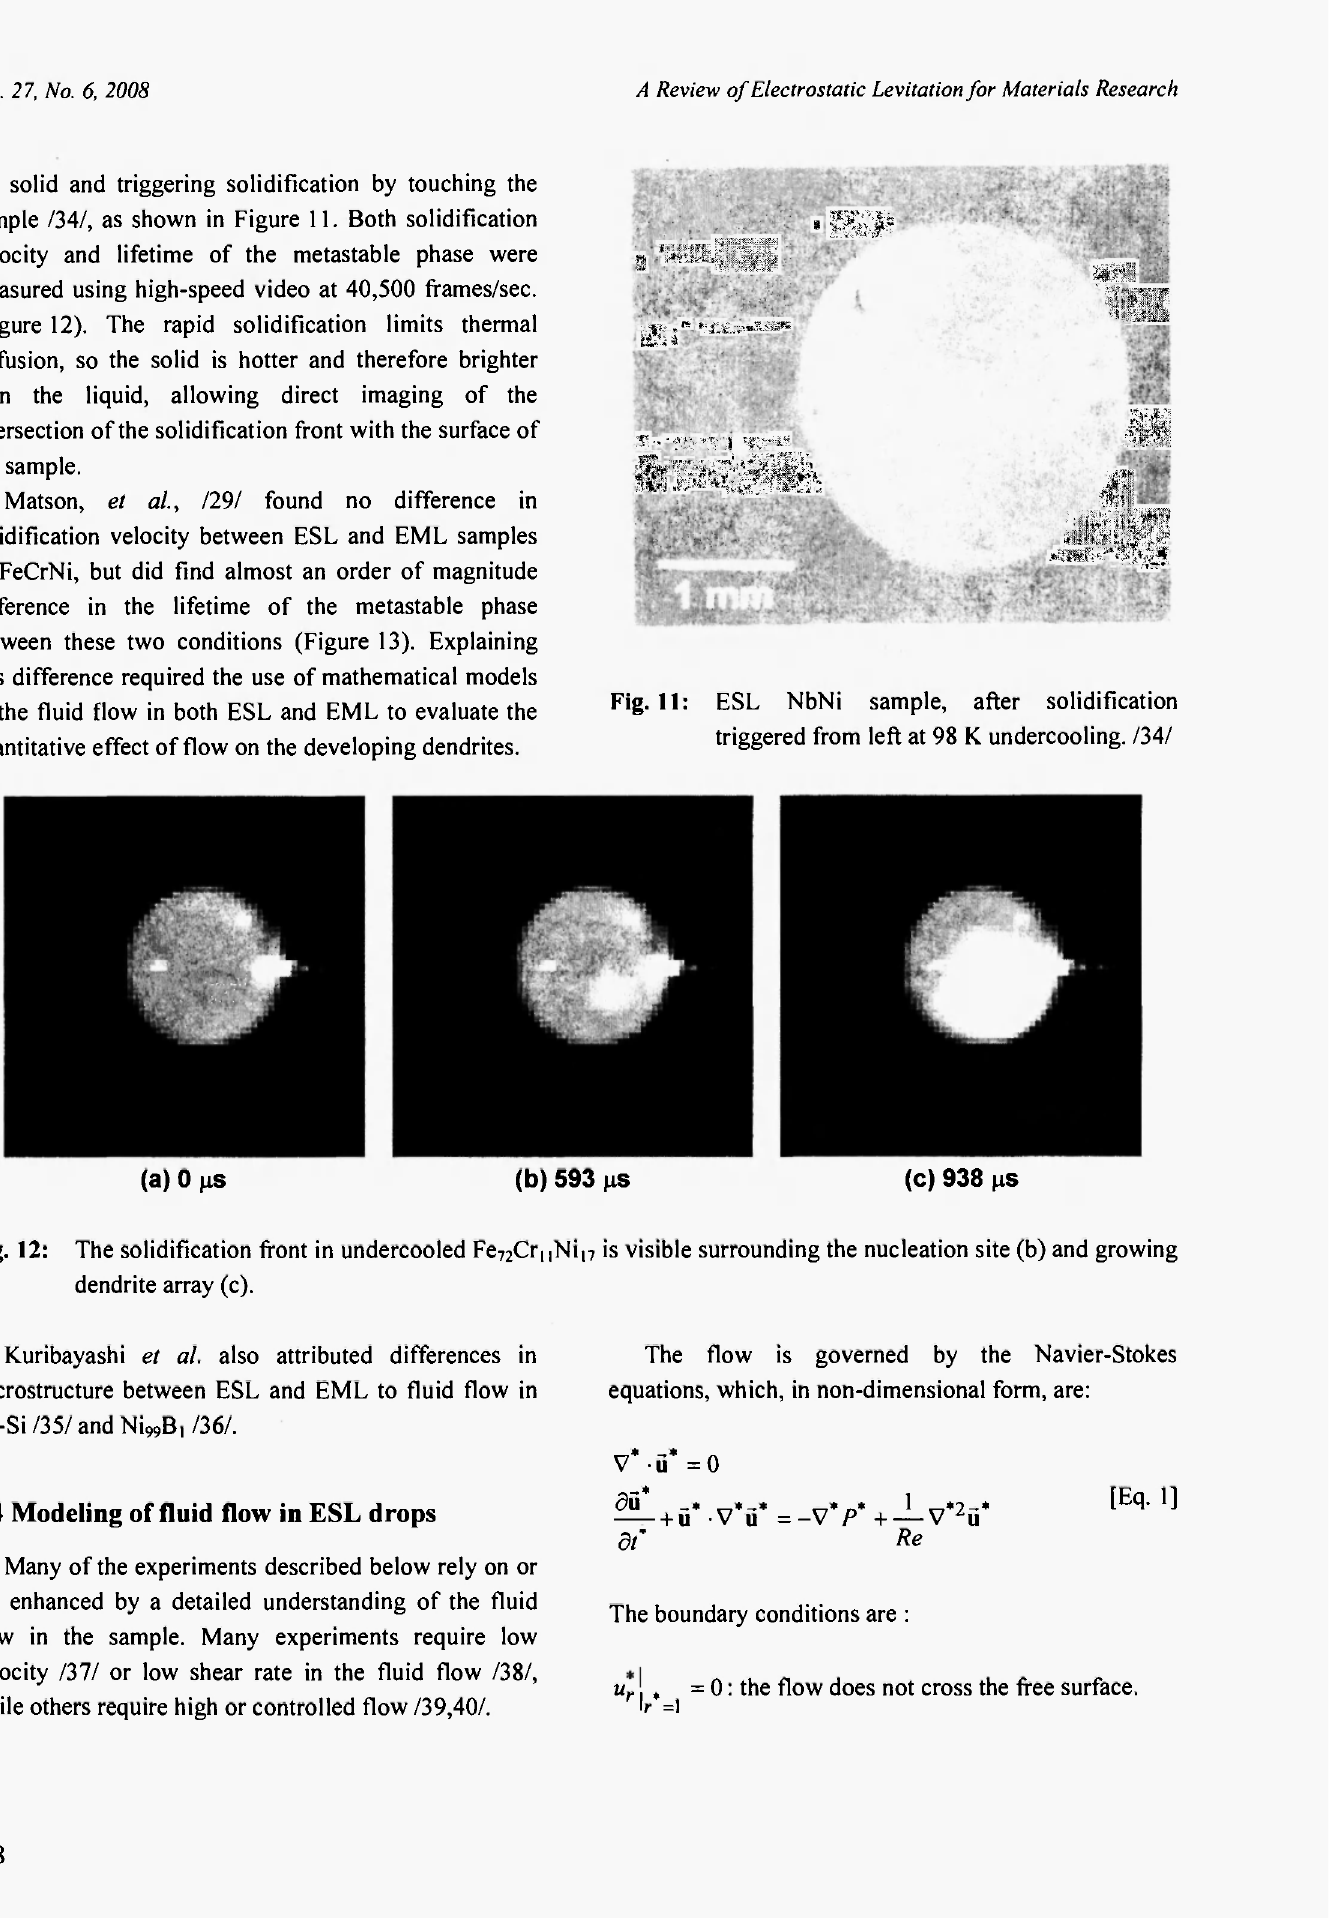
The solidification front in undercooled Fe 72 CrnNii7 is visible surrounding the nucleation site (b) and growing dendrite array